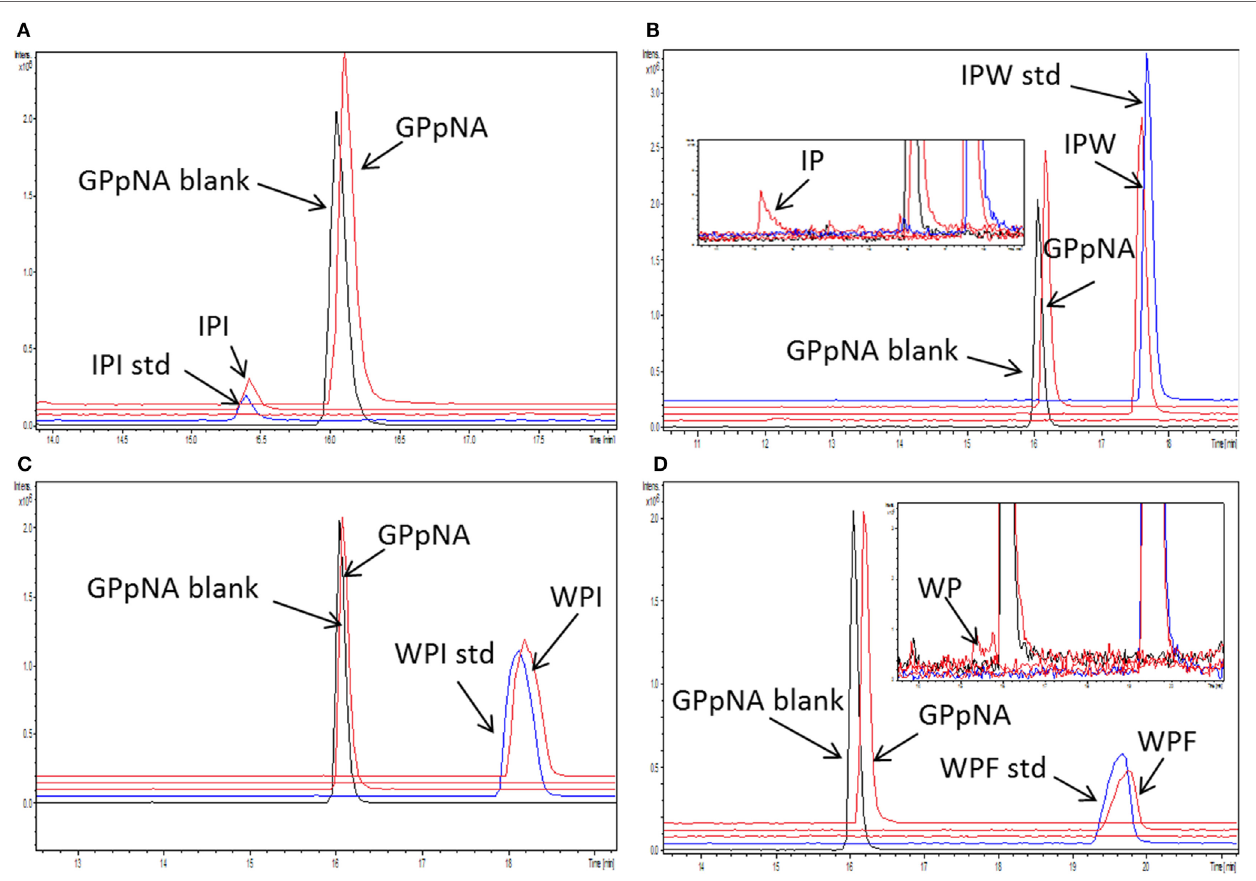
FigUre 4 | Stability of the peptides [concentration 1/4 of their half maximal inhibitory concentration (IC 50 )] during incubation with dipeptidyl peptidase IV (DPP-IV) and Gly-Pro-pNA for 30 min at 37°C in Tris–HCl buffer pH 8.0. Extracted ion chromatogram of the ultra-high performance liquid chromatography tandem mass spectrometry (MS/MS) of (a) Ile-Pro-Ile, (b) Ile-Pro-Trp, (c) Trp-Pro-Ile, and (D) Trp-Pro-Phe. peptide_std: peptide, which was not incubated with DPP-IV; GPpNA_ blank: Gly-Pro-pNA incubated with DPP-IV; peptides are abbreviated with the one letter amino acid